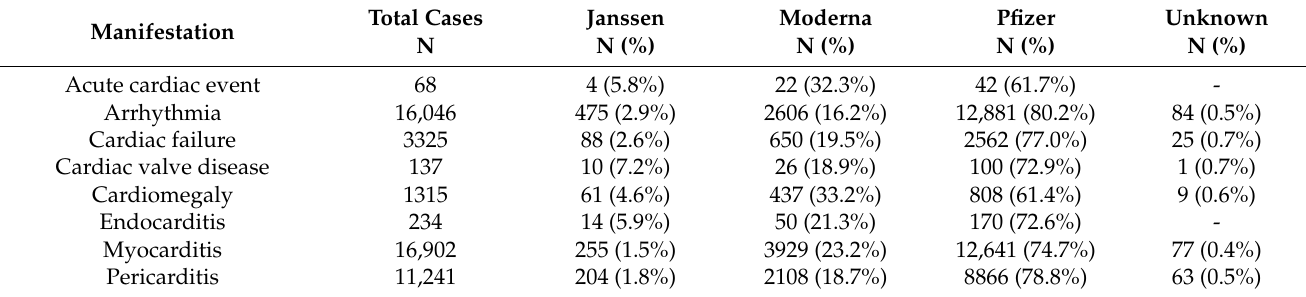
Table 3. Post-vaccine cardiovascular complications of